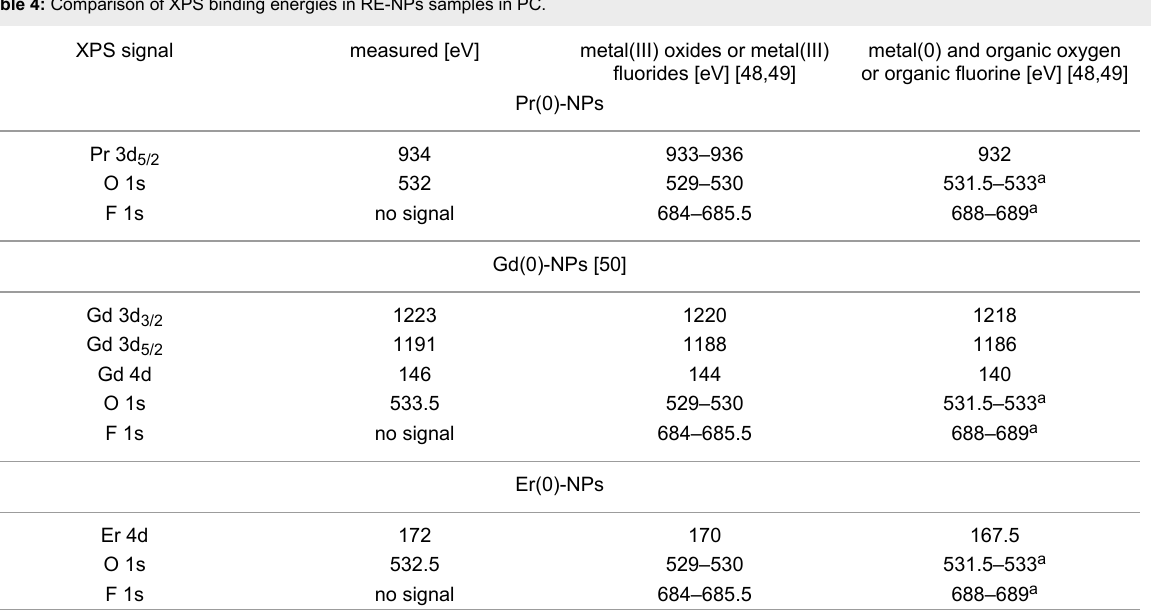
Table 4: Comparison of XPS binding energies in RE-NPs samples in